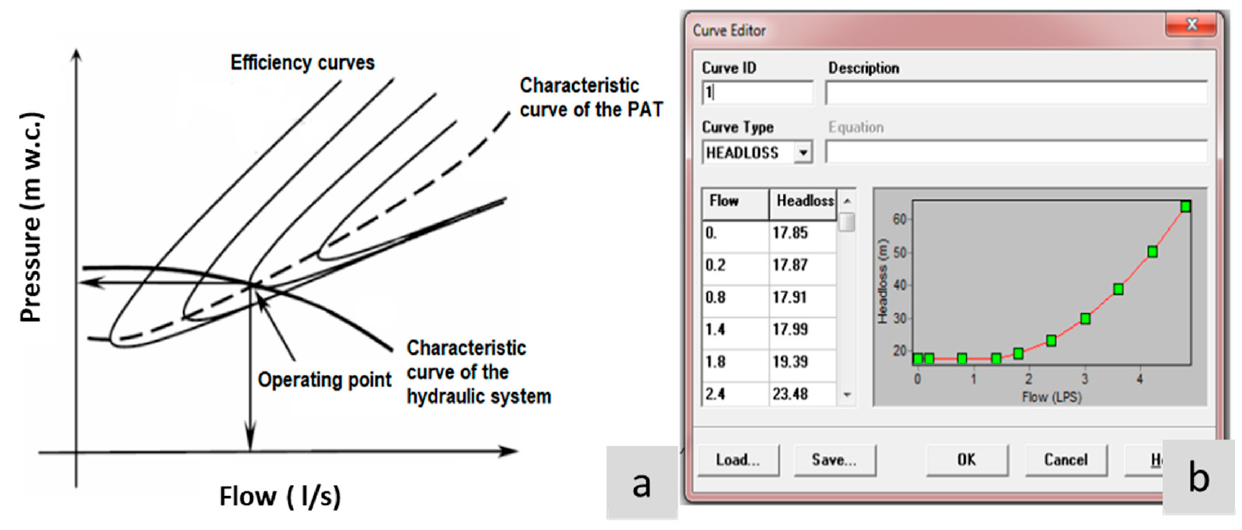
Figure 2. PAT system: ( a ) Characteristic curves and operating point; ( b ) PAT curve in the hydrant section.